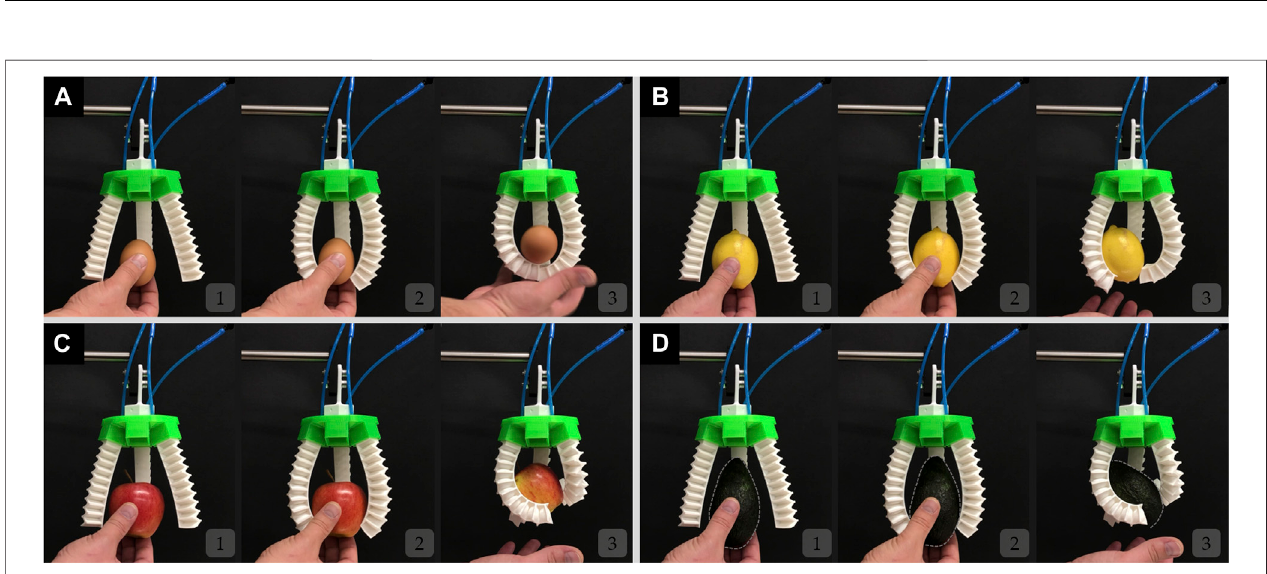
FIGURE 9 | The soft modular gripper in a three- fi nger con fi guration without the mechanical metamaterial attempts to but fails to grasp (A) an egg, (B) and fails to grasp stably a lemon, (C) an apple, and (D) an avocado.